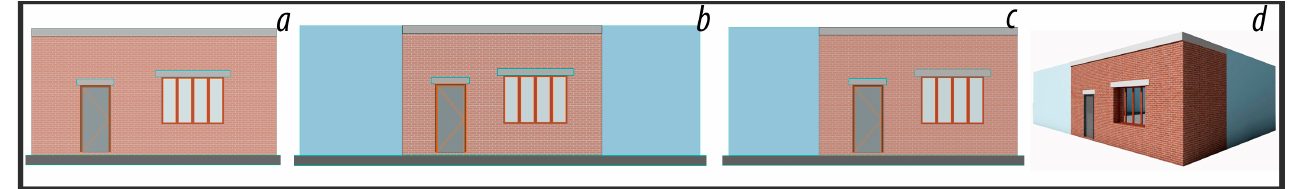
Figure 8. Structure order: ( a ) Separate, ( b ) Adjacent middle, ( c ) Adjacent edge, ( d ) Adjacent corner. If the investigated building is adjacent, floor levels should also be taken into account in these buildings (Figure 9).